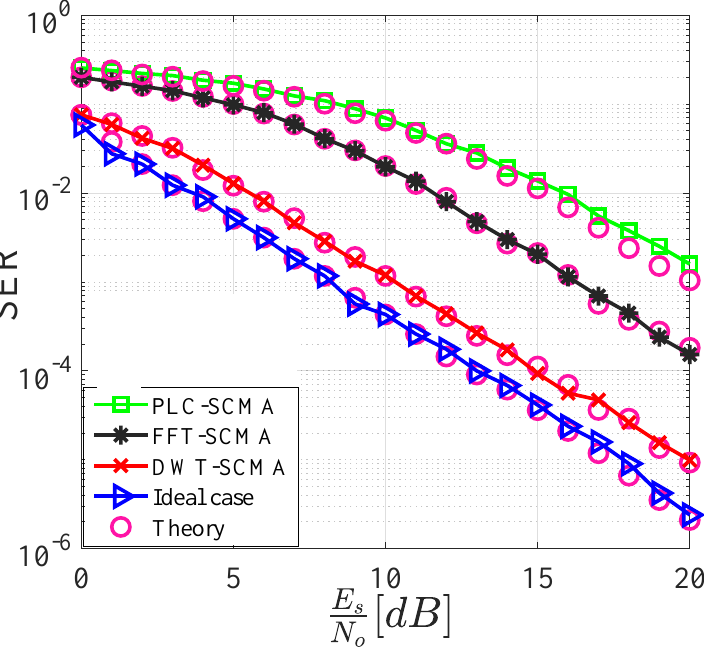
Figure 11. SER vs. E s / N o , a comparative analysis among PLC-SCMA and